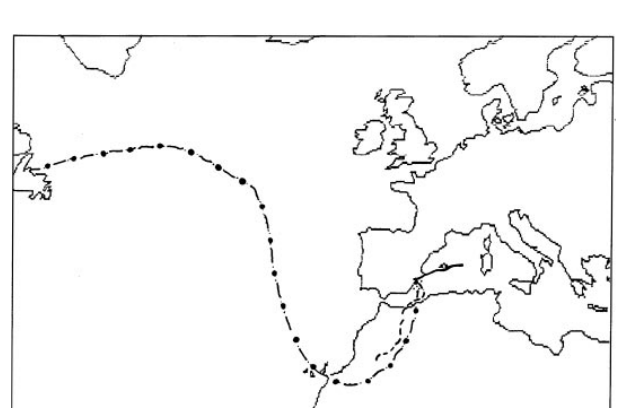
Fig. 8. The 500 hPa analysis for 1 February 1993 at 1200 UTC. Height contours, are every 60 m, ( continuous lines ) and temperature contours are every 4 (cid:176) C, ( dashed lines